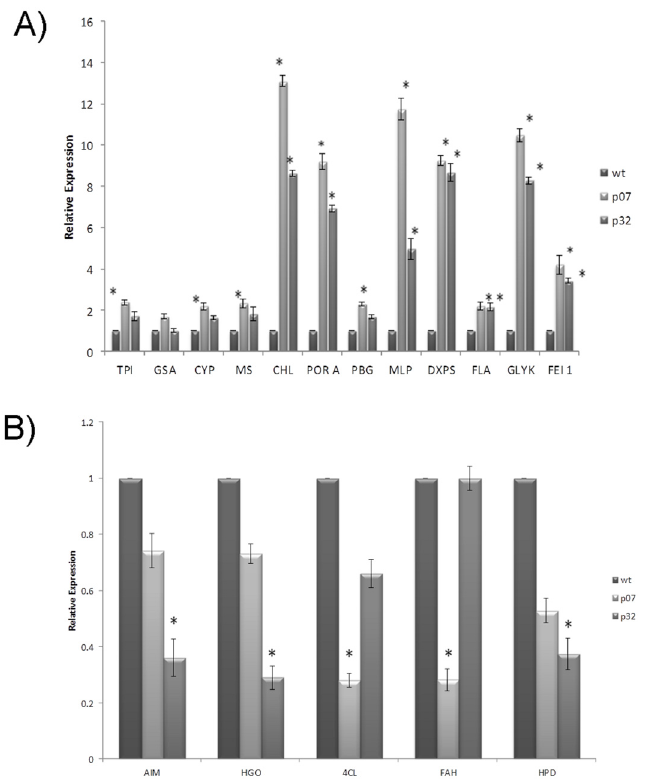
Fig 6. RT-qPCR validation of a set of differentially expressed genes. (A) Validation of the selected up- regulated genes. (B) Validation of the selected down-regulated genes. Assays were performed using the same RNA samples used for RNA-sequencing of both OE lines (P07 and P32) and WT expression was set to 1. Bars indicate standard errors of triplicate reactions ( * means p <